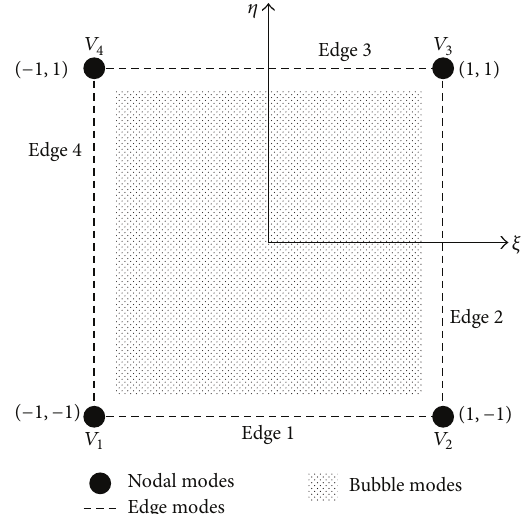
Figure 2: Two-dimensional 𝑝 -convergent element on standard